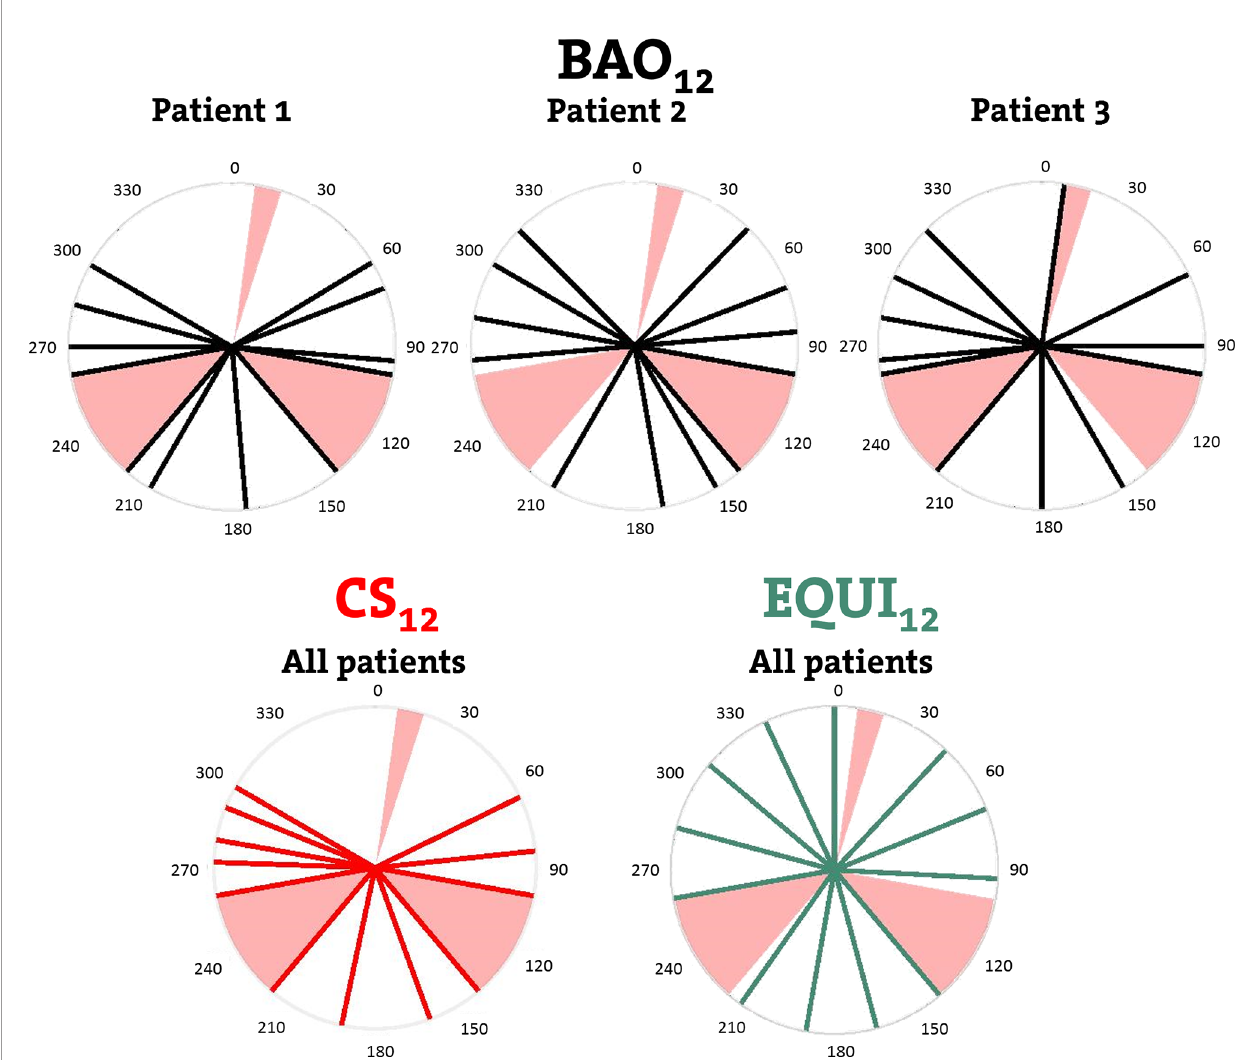
FIGURE 1 | Upper row: individualized beam angles of the 12-beam plans for three example patients, generated with integrated beam pro fi le and angle optimization (BAO). Lower row: beams for CS 12 , the 12-beam class solution, and for EQUI 12 , the 12-beam equi-angular setup. Black, red and green lines represent treatment beams. Beam avoidance areas (BAAs) for the Unity MRL are depicted in